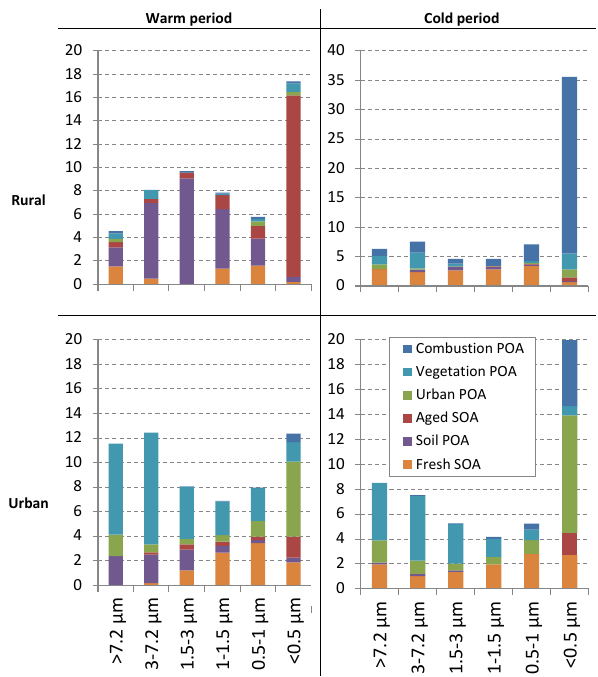
Figure 6. The average P score values of the six components for the different size fractions in the warm and cold period for the rural and urban site, obtained from the MCR-ALS resolved profiles for the organic compound